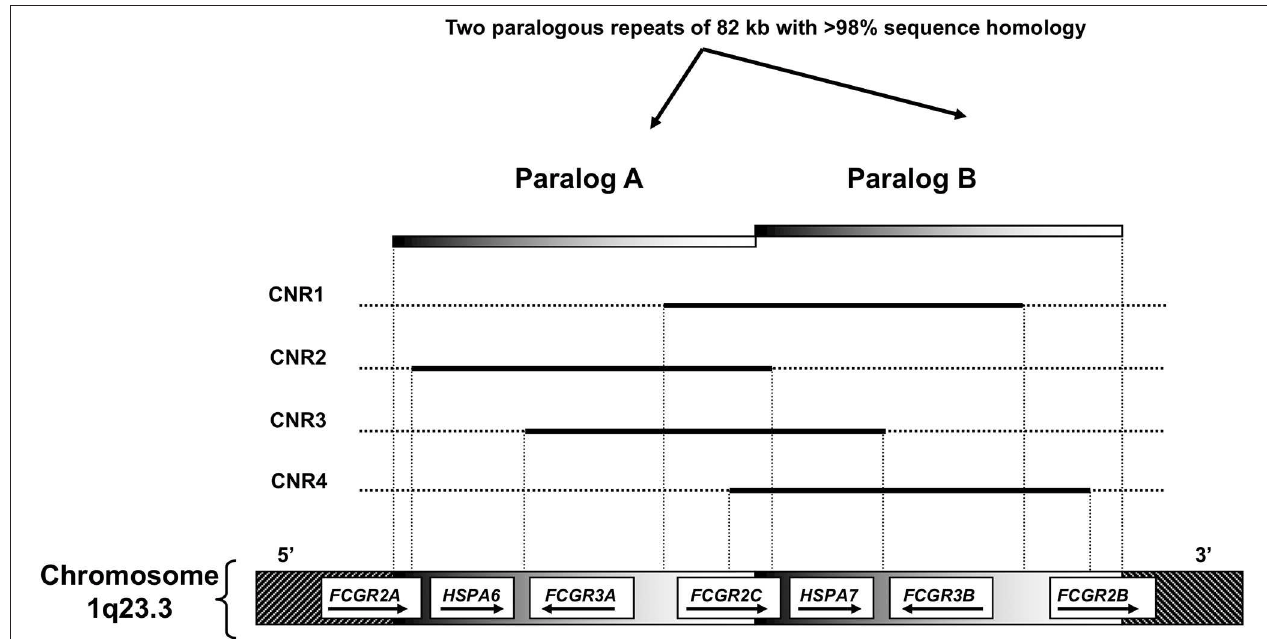
FIGURE 2 | Overview of the FCGR2/3 locus. A Structural overview of the locus, with the orientation of the genes indicated by arrows. B Overview of copy number variation at the locus. Four combinations (copy number variable regions, CNRs) of Fc γ R genes have been shown to occur in duplication/deletion. Black lines indicate which genes are involved in copy number variation (CNV).